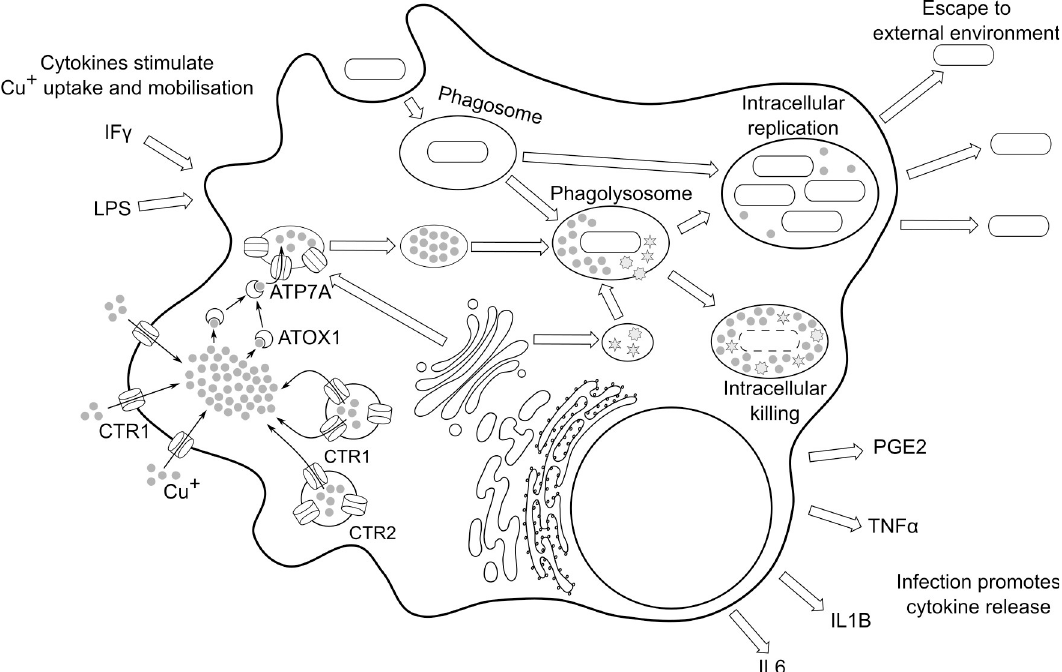
Golgi apparatus and drives copper accumulation in the early lysosome. Upon phagocytosis of an invading microorganism, the maturing phagosome fuses with copper-rich lysosomes, exposing the microorganism to high copper levels. If copper fails to accumulate in the phagolysosome, lysis of engulfed bacteria is compromised and intracellular proliferation can occur. Copper is also required for the biosynthesis of many extracellular signals, including PGE2, TNF α , and IL1B and IL6. IF γ , interferon- γ ;